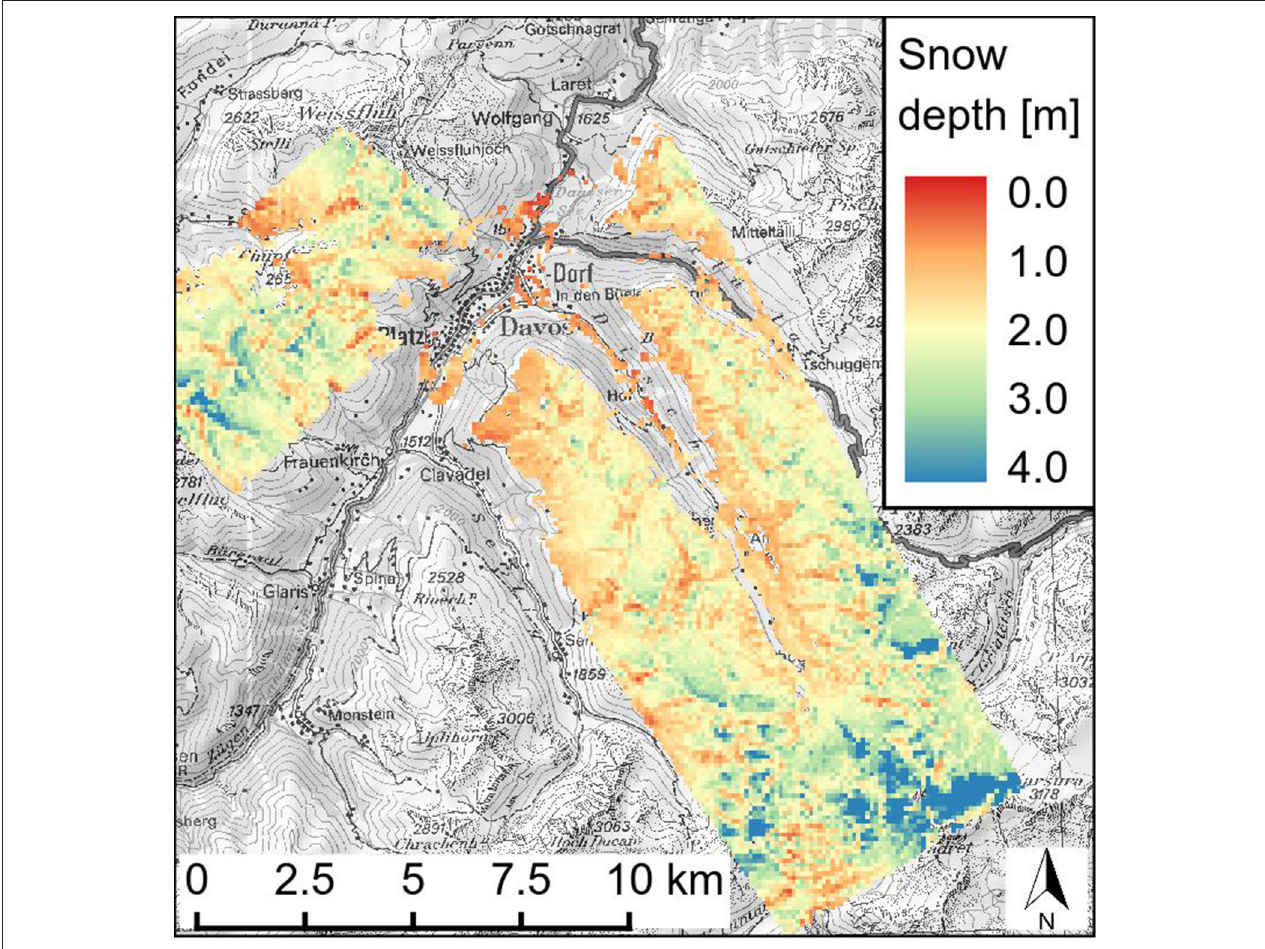
FIGURE 2 | ADS snow depth map from 20 March 2012 resampled at 100m resolution. Legend shows snow depth [m] and correspond to the 2–98 cumulative percentage of data. Map reproduced by permission of swisstopo (JA100118).